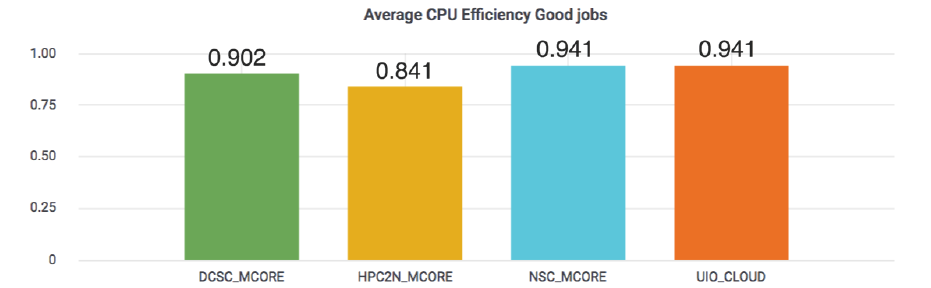
Figure 10: Average CPU e ffi ciency for the Nordic Tier 1 sites, averaged over a period of 2 weeks.